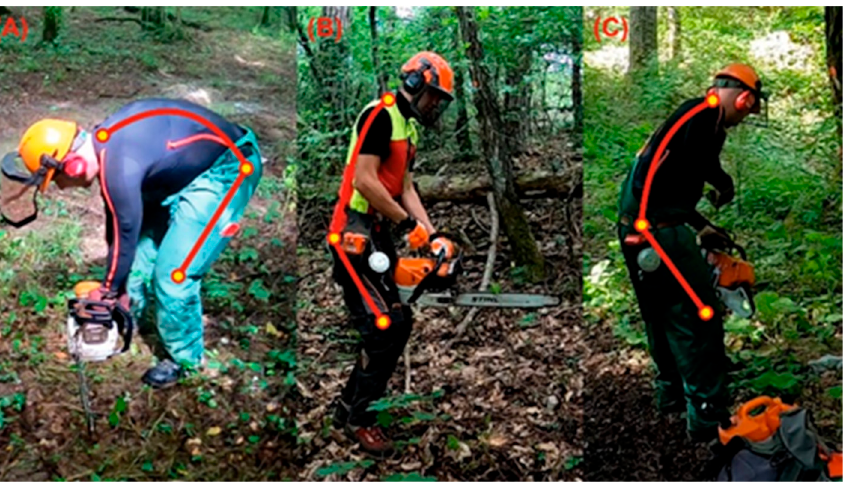
Figure 1. The example of three methods for starting the chainsaw (( A ) from the ground, ( B ) between the knees, ( C ) “drop starting”).